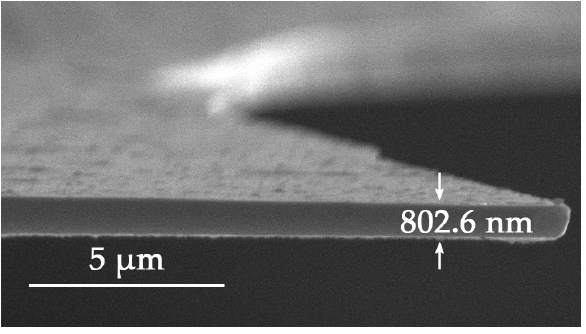
Figure 2. SEM image of the heavily boron-doped layer after TMAH etching, the thickness is about 800 nm.